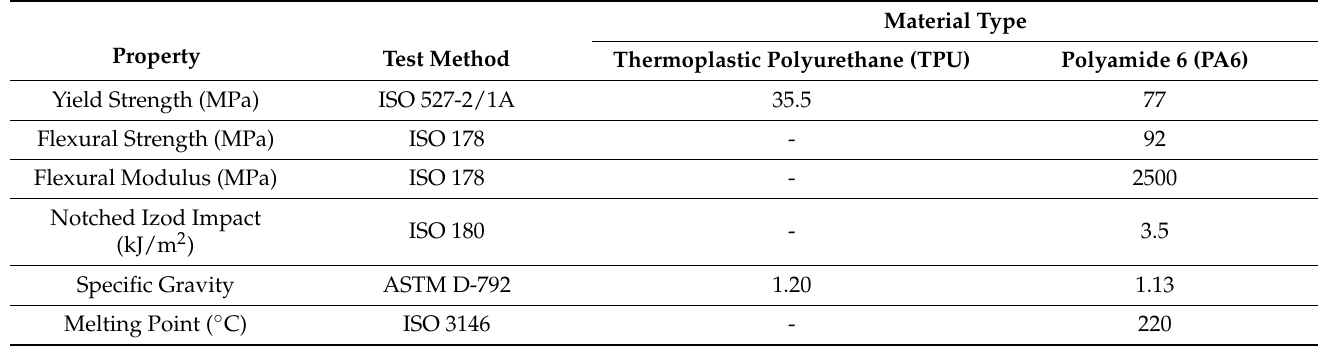
Table 1. Physical properties of polymeric materials.